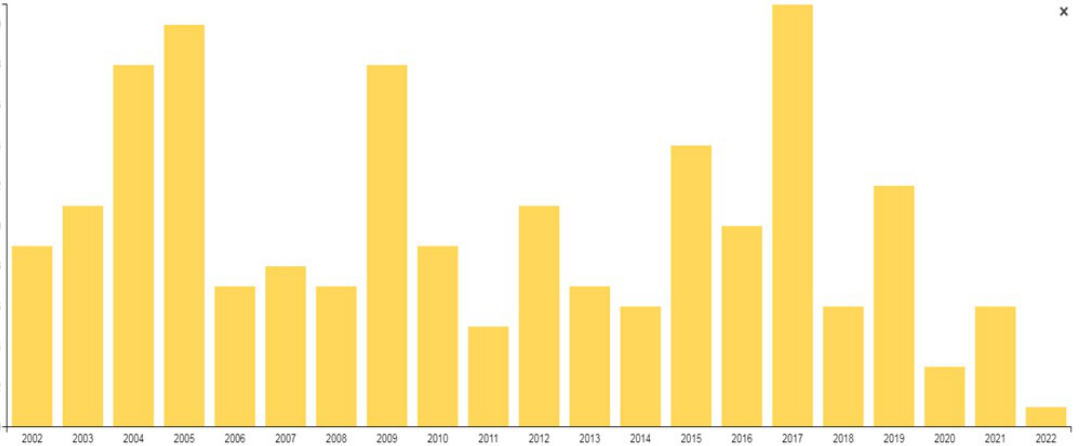
Figure 6. Number of patents between 2002 and 2022 registered with IPC and/or CPC F25D11/02 numbers